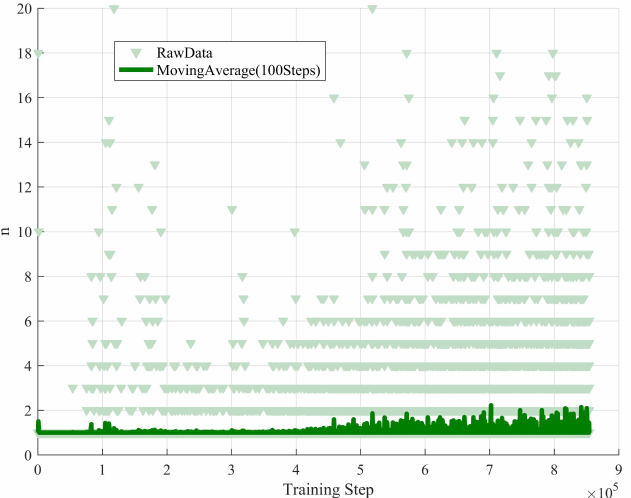
Figure 6. The number of RBT iterations that occur during RBT-DDPG training. RBT is repeated several times at the beginning of training (near the first training iteration), and CN is required to train to a tiny estimation error. RBT is barely executed before 60,000 training steps, as CN can already provide accurate estimates for the samples in the current memory pool, and no additional training is needed. From steps 100,000 to 200,000 , RBT is repeated several times, and many of the executions are greater than 10. Due to the introduction of new strategies into the memory pool, the original CN does not accurately estimate the Q value, so additional training is performed. Between steps 20,000 and 35,000, RBT is occasionallyexecuted, and most executions contain less than 10 repetitions because fine-tuning CN can accommodate the new strategies that are explored by the actor. RBT executions increase after 350,000 steps, as CN must adapt to the multiple strategy samples brought into the memory pool. At the end of training, the average -number of repetitions is approximately 2, which is an acceptable algorithmic complexity